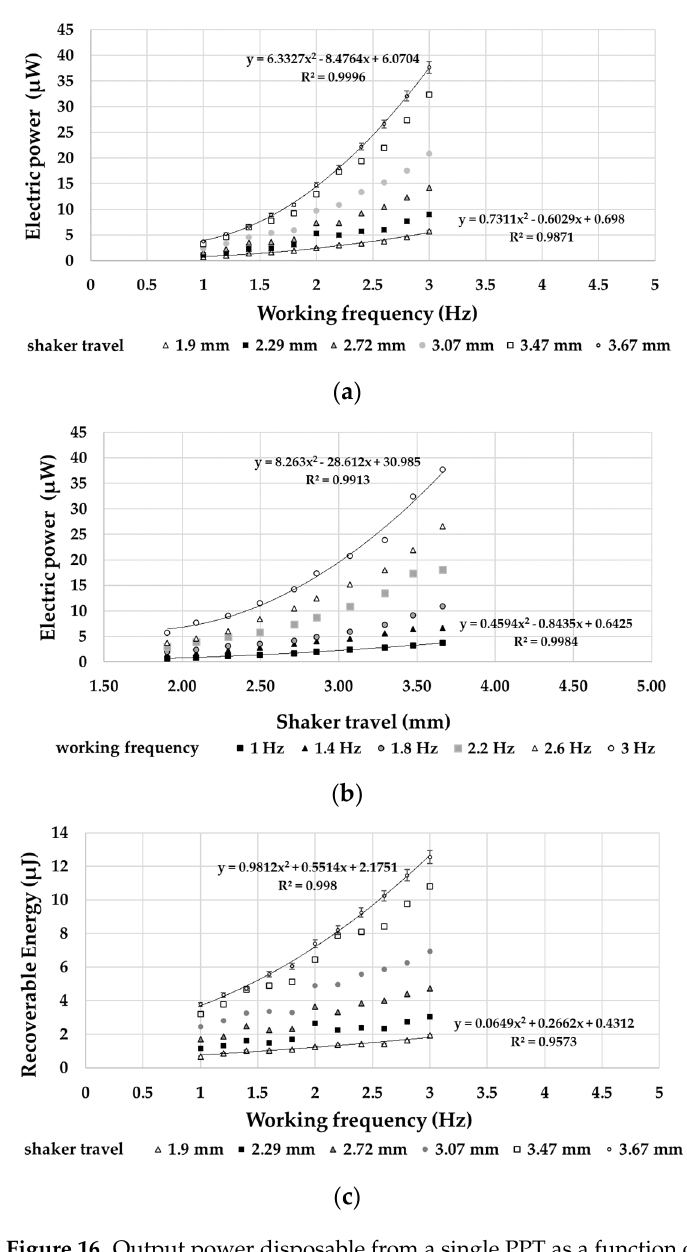
Figure 16. Output power disposable from a single PPT as a function of ( a ) frequency and ( b ) shaker travel, ( c ) energy recoverable from a single PPT.